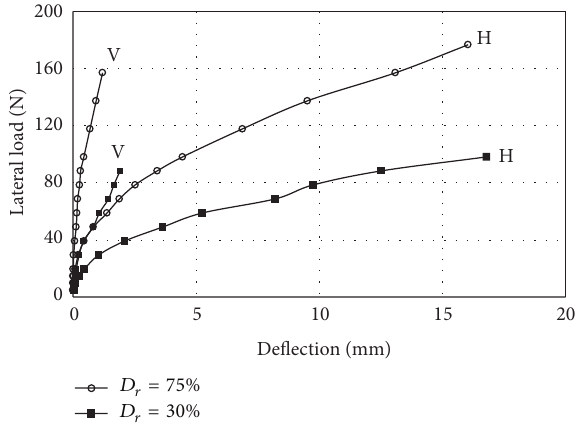
Figure 4: Lateral load versus deflection diagram for single pile (H=horizontal; V=vertical).